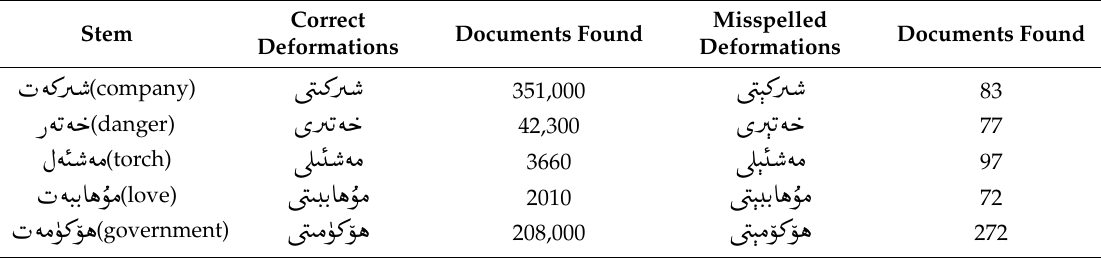
Table 2. Misspelling examples and their actual occurrences on web pages (searched using Bing). Correct Stem Documents Found Deformations